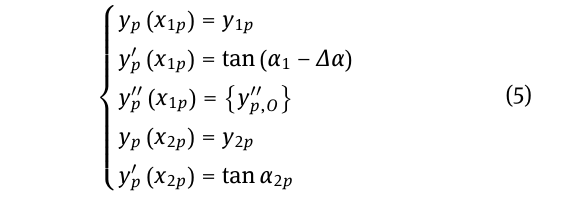
Figure 3: View of the rotor in the meridional plane Figure 3. View of the rotor in the meridional plane and 4-th order, respectively: